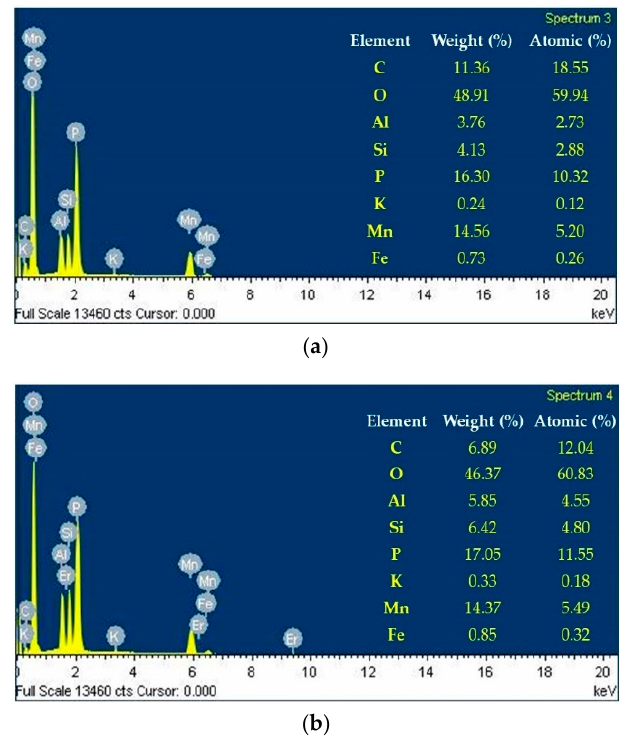
Figure 5. EDX analysis of the MV pigment: ( a ) Room temperature; ( b ) 410 ° C.